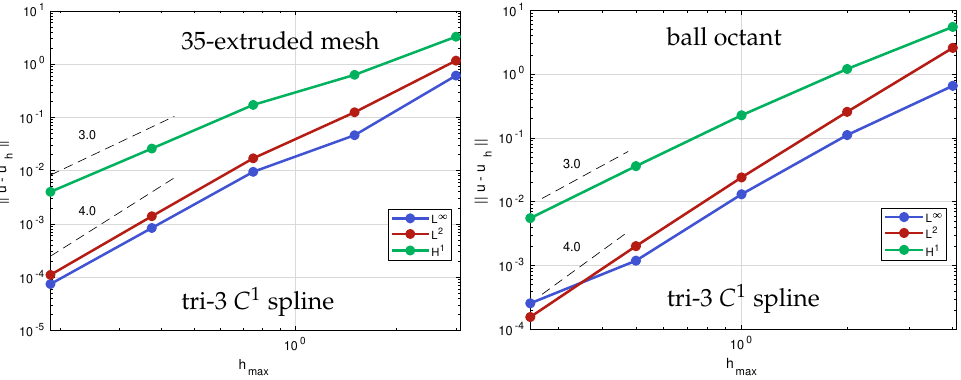
Figure 6. Poisson’s equation solved in terms of the tri-3 C 1 spline. Error norms decreasing with h . The dashed lines labeled with n show slopes of 2 − n